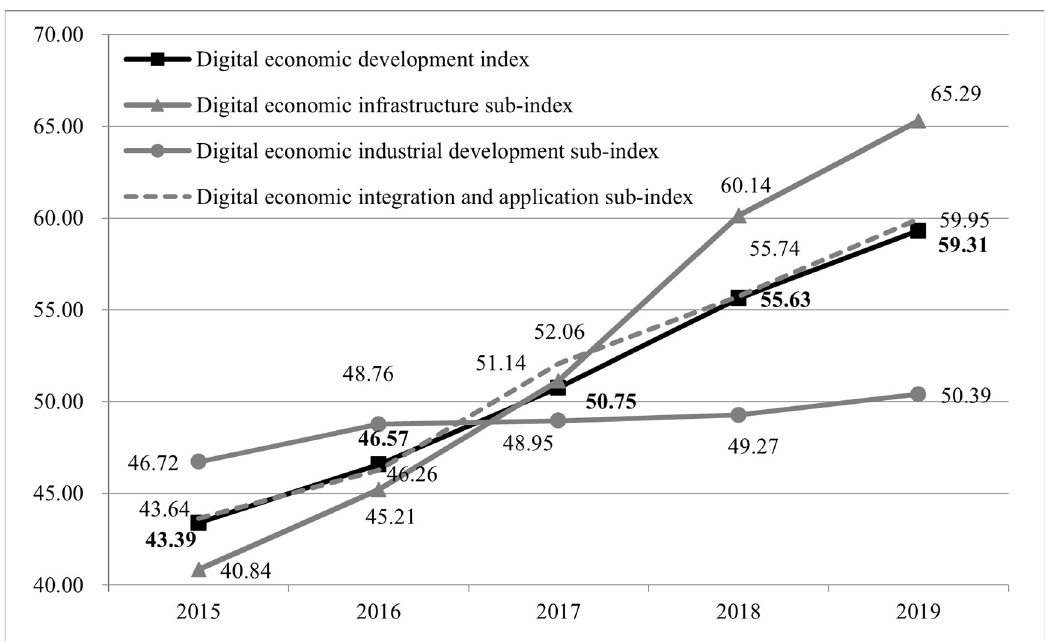
Fig 1. Changes in China’s interprovincial digital economic development index and in its three sub-indices from 2015 to 2019.